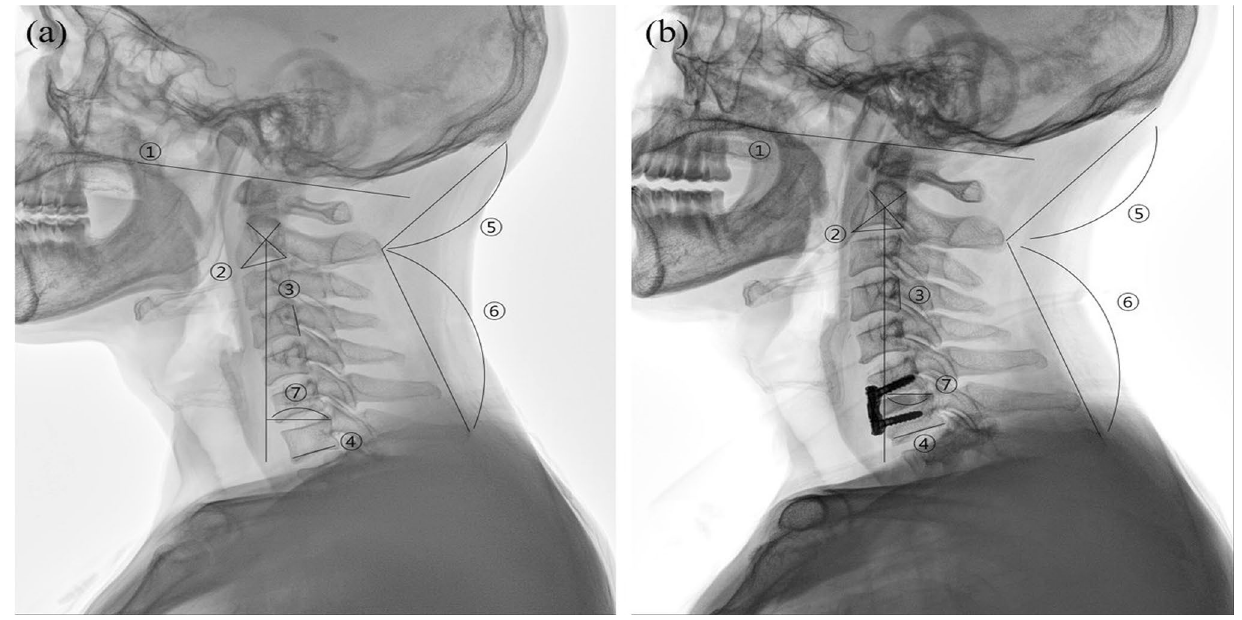
Figure 1. Example of measurements and landmarks of the occipitocervical and subaxial cervical parameters. A 55-year-old man who underwent ACDF on C6-7 due to soft disc herniation ( a ) Preoperative lateral X-ray ( b ) Postoperative follow-up lateral X-ray. Note the increment of CL and OC2D and decrement of OC2A and C27SVA. ① McGregor line ② C2 lower endplate ③ posterior border of the fourth cervical vertebral body ④ C7 lower endplate ⑤ distance between external occipital protuberance and most prominent portion of C2 spinous process (OC2D) ⑥ distance between the C2 and C7 spinous process (C27D) ⑦ shortest distance between the plumb line from the center of second cervical vertebrae body and posterosuperior corner of seventh cervical vertebrae body (C27SVA). OCI, angle between ① and ③ ; OC2A, angle between ① and ② ; CL, angle between ② and ④ . Lordotic angle is measured as positive value, and kyphotic angle is measured as negative value. Positive C27SVA indicates that the C2 plumb line is anterior to posterosuperior corner of C7 body and vice versa. ACDF, anterior cervical discectomy and fusion; CL, cervical lordosis; OC2D, occiput-C2 distance;